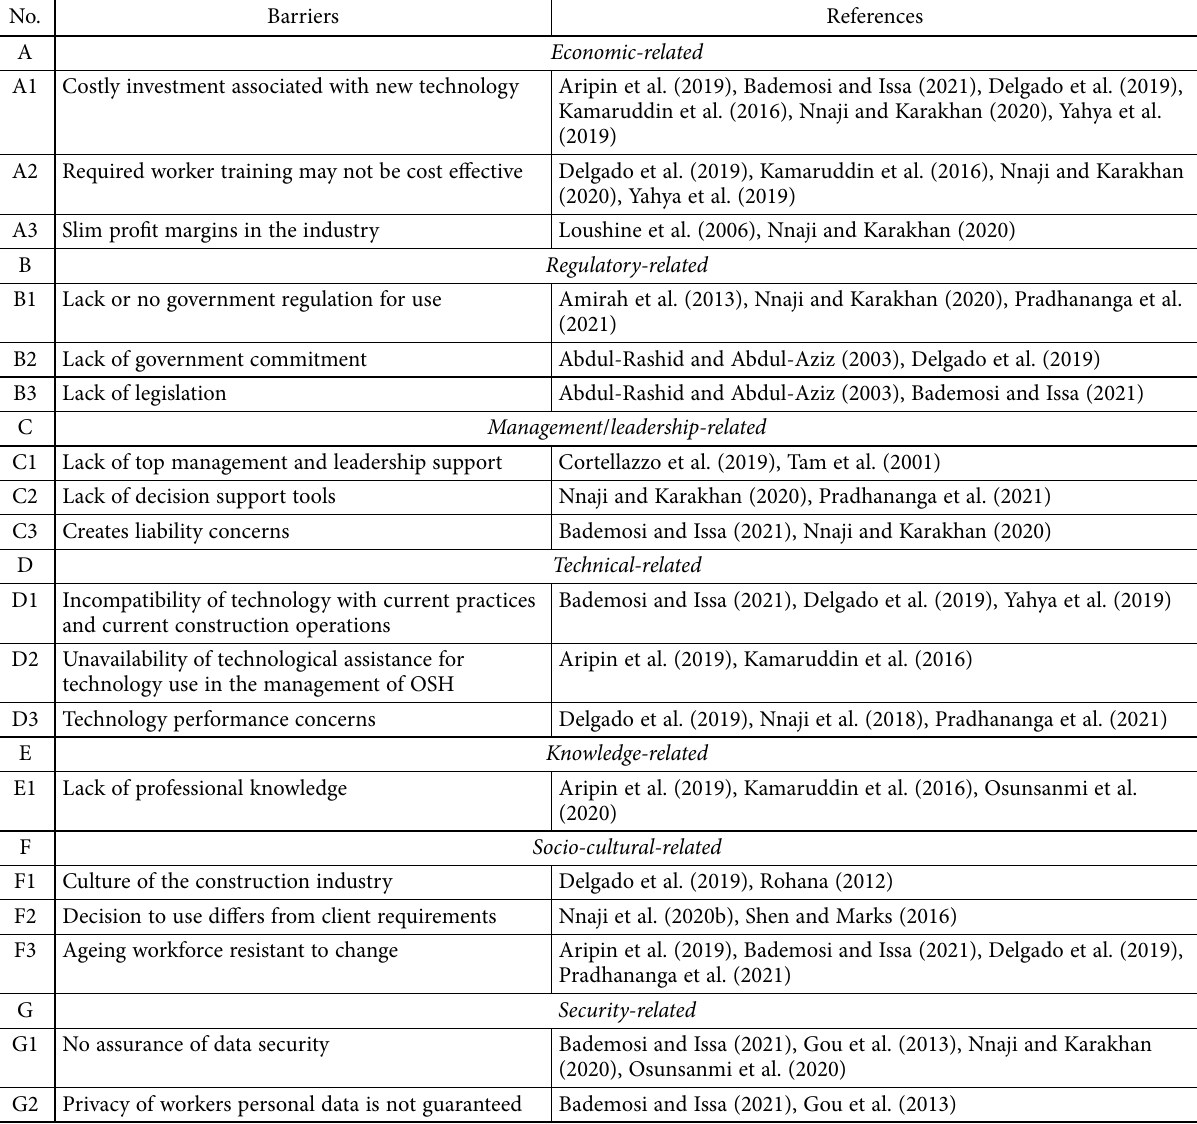
Table 1. Summary of barriers to safety technology adoption in